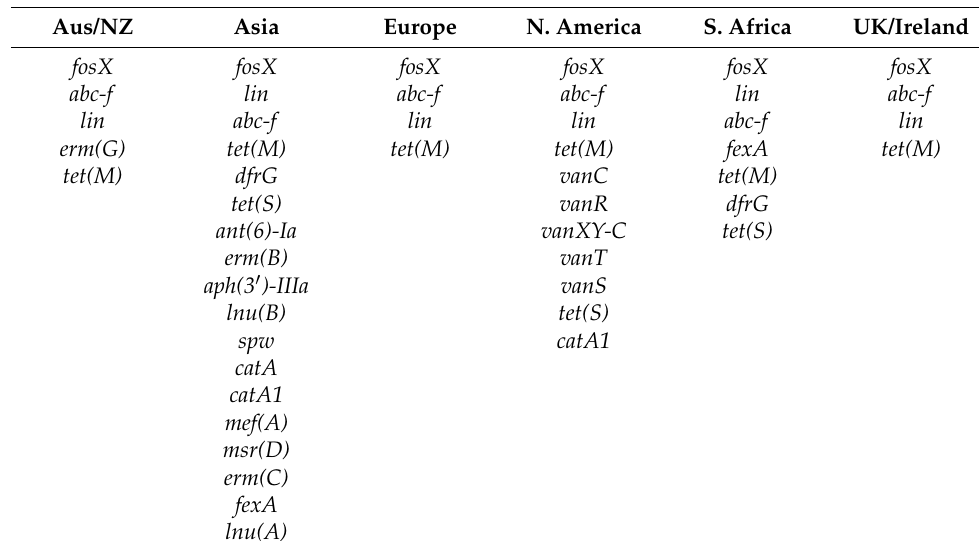
Figure 5. PCA ( A ) of regions on the basis of AMR genes; HC ( B ) of regions on the basis of AMR genes. Table 3. Highly occurring AMR genes by